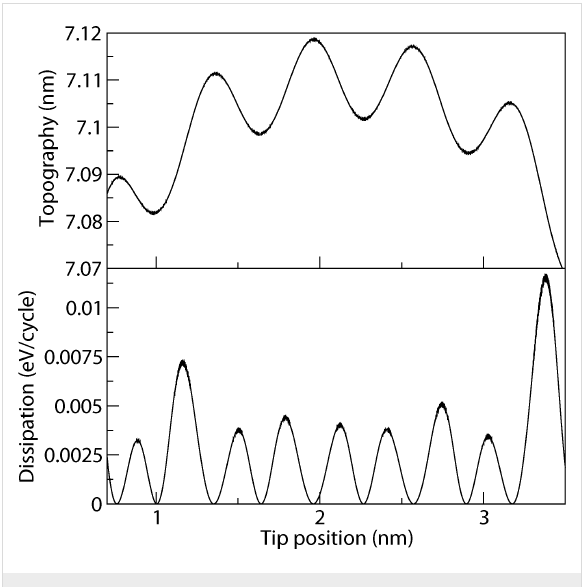
Figure 7: Topography and dissipation for KBr. Scan line along [010]. We observe a doubling in the dissipation